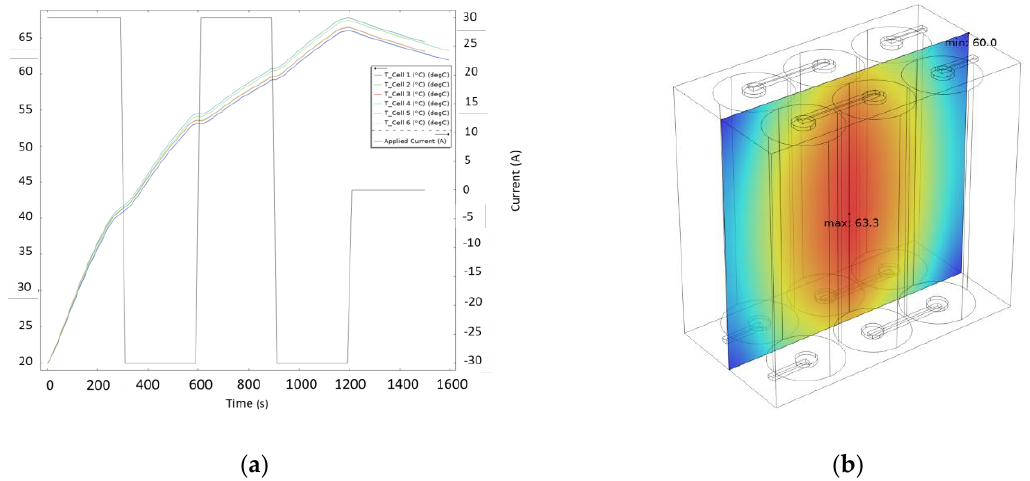
Figure 14. ( a ) Temperature rises inside the batteries vs. applied current for the model with the GNP as heat spreader; ( b ) temperature distribution inside the GNP layer.